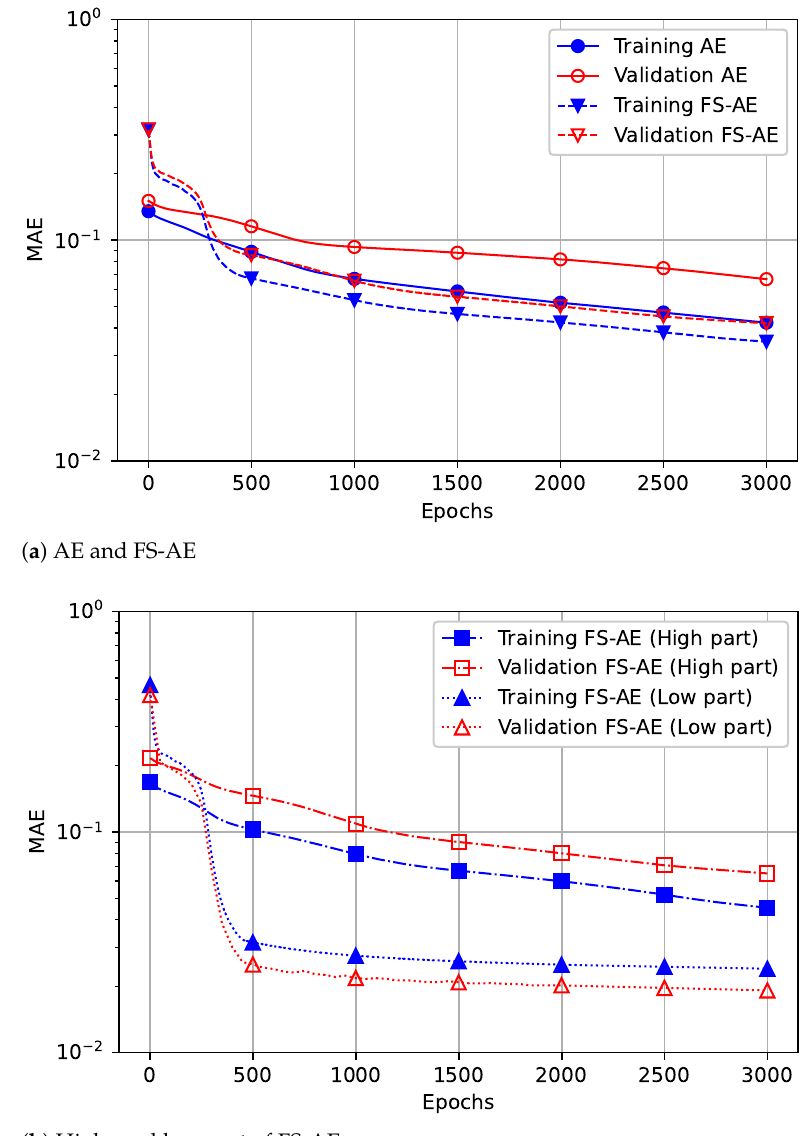
Figure 7. Comparison of the speed of convergence for the training and validation loss (mean absolute error (MAE)) by ( a ) the existing and the proposed method, ( b ) the high- and low-frequency part of the proposed method, each applied for half of the test